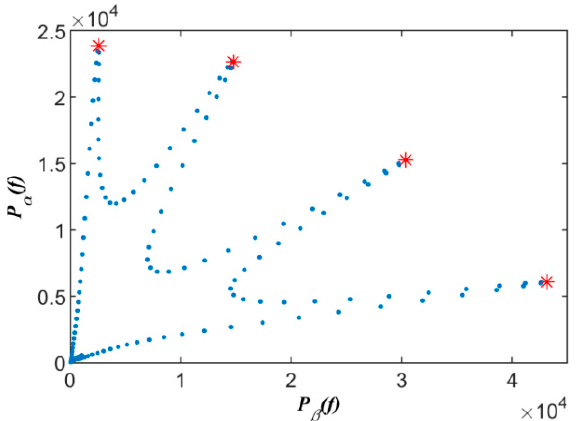
Figure 6. The power scatters of mixed signals after detection. The flowchart of the proposed strategy is shown in Figure 7. Firstly, the angular distribution θ is converted from the power ratio by Equation (8); Secondly, the number of source signals ˆ n is estimated through the KDE algorithm followed by the peak density detection; Afterwards, the contribution degree η of the source signal in the observed signal is calculated by the contribution degree function based on the cosine distance d . Finally, the TF soft mask matrix M is constructed based on the contribution degree η , and the separated TF signals are reconstructed.